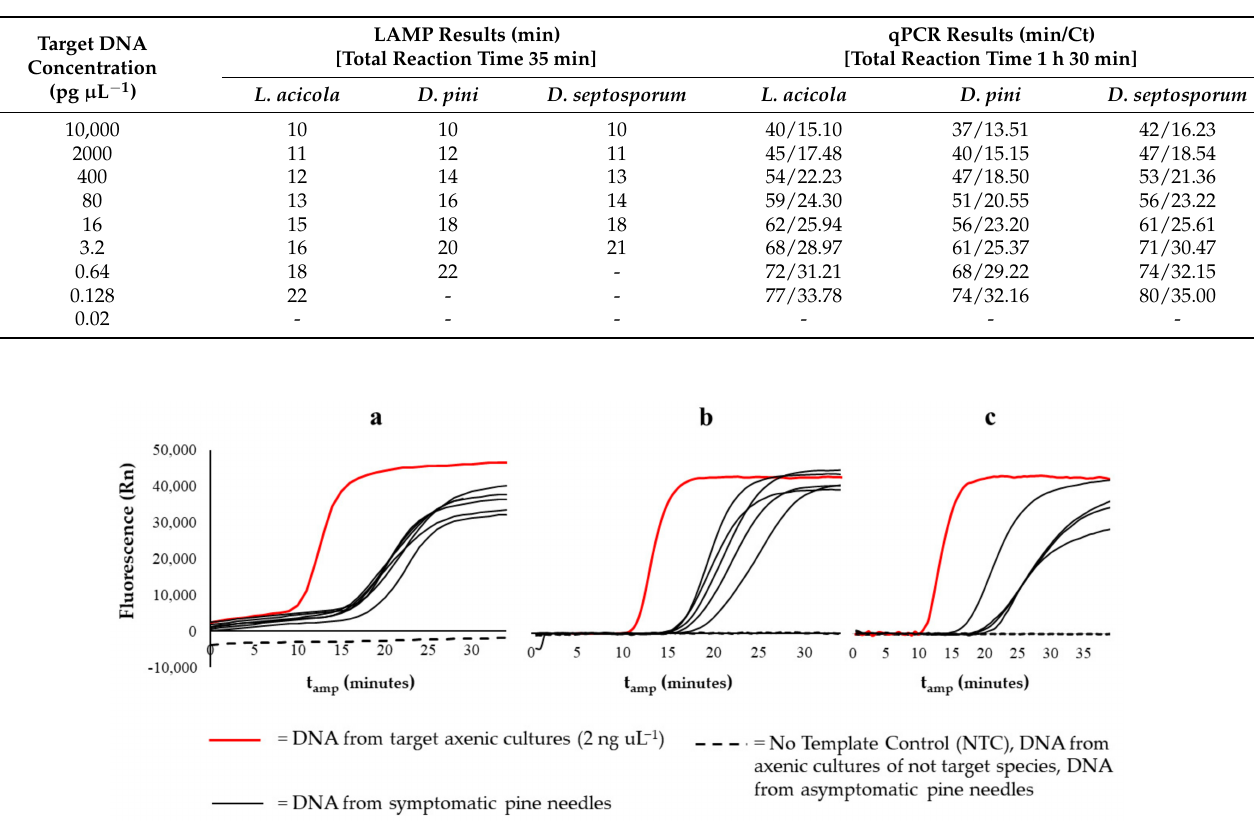
Table 4. Comparison of the sensitivity of the LAMP assays developed for the detection of Lecanosticta acicola, Dothistroma pini and D. septosporum , respectively, and the qPCR assay described by [46]. Tested DNA was obtained from axenic cultures of each target species. LAMP results are shown as time of amplification (min) while qPCR results are shown as time of amplification (min) and cycle threshold (Ct).